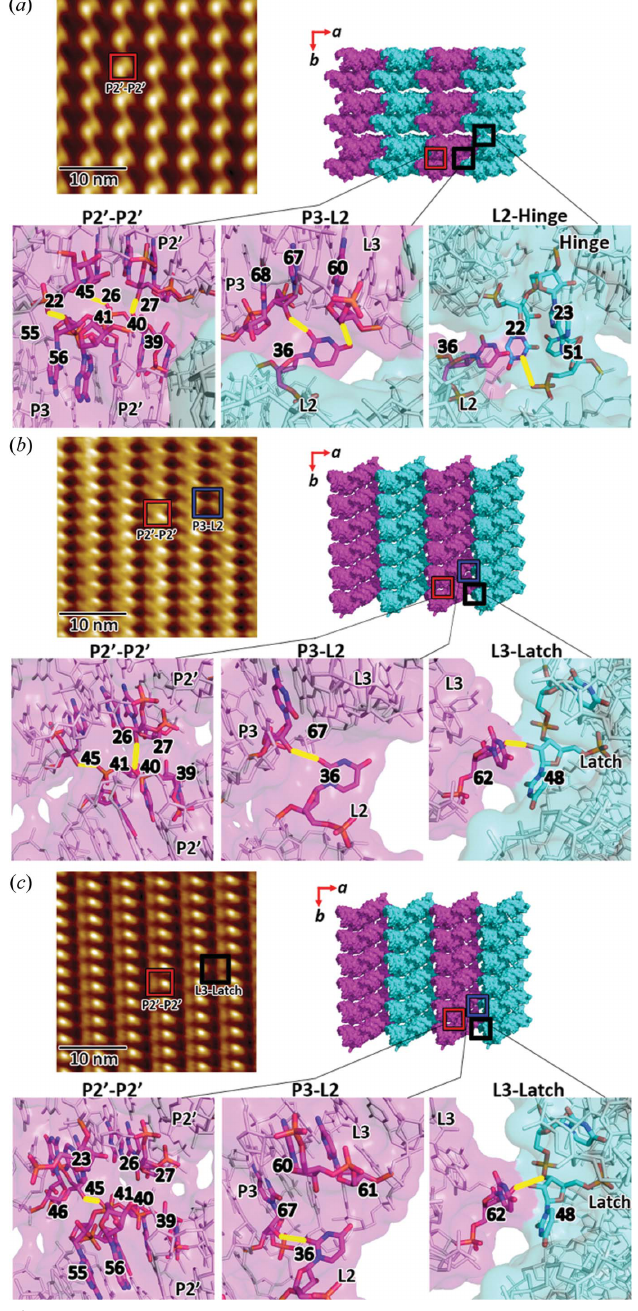
Figure 3 Crystal packing in the ab plane of ( a ) AUC, ( b ) TUC1 and ( c ) BUC, as observed by continuous AFM of the same crystal, and the associated structures determined by X-ray crystallography. The molecular interfaces (P2 0 –P2 0 , P3–L2, L3–latch) observed in AFM images are highlighted with colored boxes. The atomic interactions at each interface are shown as sticks with transparent molecular surfaces. Hydrogen-bond interactions are drawn as yellow lines. The unit-cell dimensions derived from X-ray diffraction or AFM are listed in Tables S3 and S4. AFM images are 30 (cid:8) 30 nm in size and 0.5 nm in height (dark-to-light color scale). Ligand concentrations for AFM and TRX experiments were 0.05 and 10 m M ,